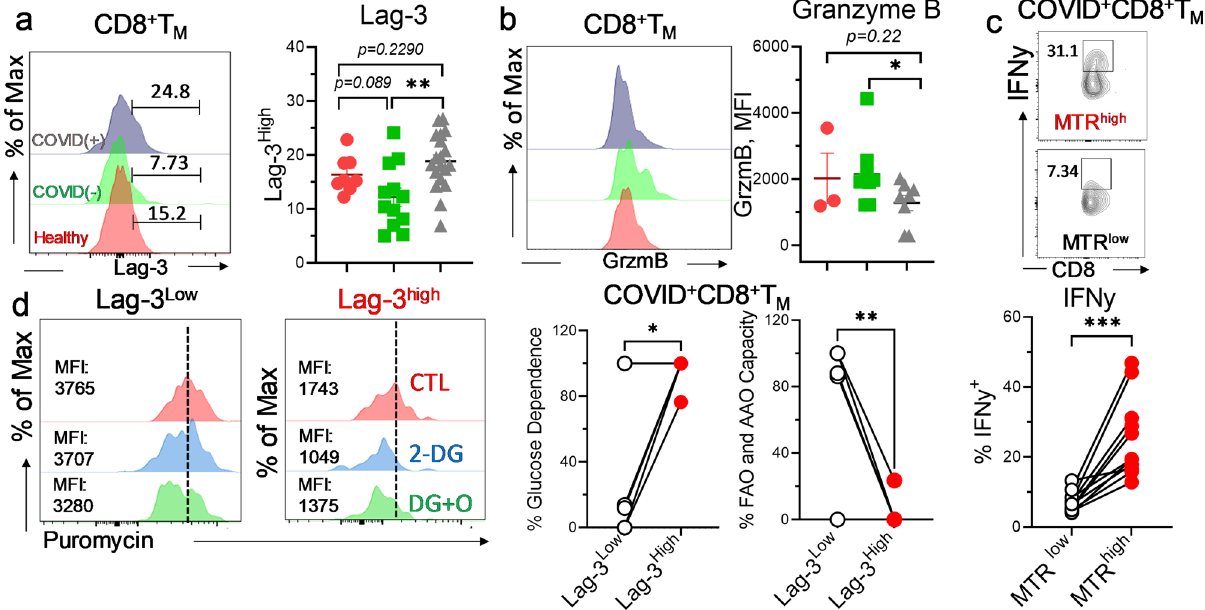
Fig. 6 Metabolic dysregulation triggers functional impairment in CD8 + T M . Freshly isolated PBMCs were evaluated for cellular function and metabolic phenotype by fl ow cytometry. a , b Representative histogram and summary graphs demonstrating the expression abundance of lag-3 + CD8 + T M ( n = 8 HD, 12 C − , 19 C + ) ( a ) and grzmB expression (n = 3 HD, 9 C − , 8 C + ) ( b ) in CD8 + T M from healthy, COVID( − ), and COVID( + ) patients. c Representative contour plot and summary paired graph demonstrating IFNy + cells in MTR low and MTR high CD8 + Tc from COVID( + ) patients ( n = 11). d Summary paired graphs demonstrating glucose dependence and FAO/AAO capacities of lag-3 low and lag-3 high CD8 + T M from COVID( + ) patients ( n = 5). b , d three samples are excluded due to critically low CD8 + T M count; in a , one sample was excluded due to critically low CD8 + T M count. Two-tailed student ’ s t test was used. * p < 0.05, ** p < 0.01, and *** p < on glycolysis for their bioenergetics demands (Fig. 7a, b). Clustering and shared upregulation of glycolytic enzyme encoding genes GALM, GAPDH, GPI, and ALDOA together with HIF1A , and transcripts regulating exhaustion ( TIGIT and LAG3 ) (Fig. 7b) suggested that hypoxia/anaerobic axis is associated with impaired CD8 + T M function in COVID-19 BALF. FAO and OXPHOS